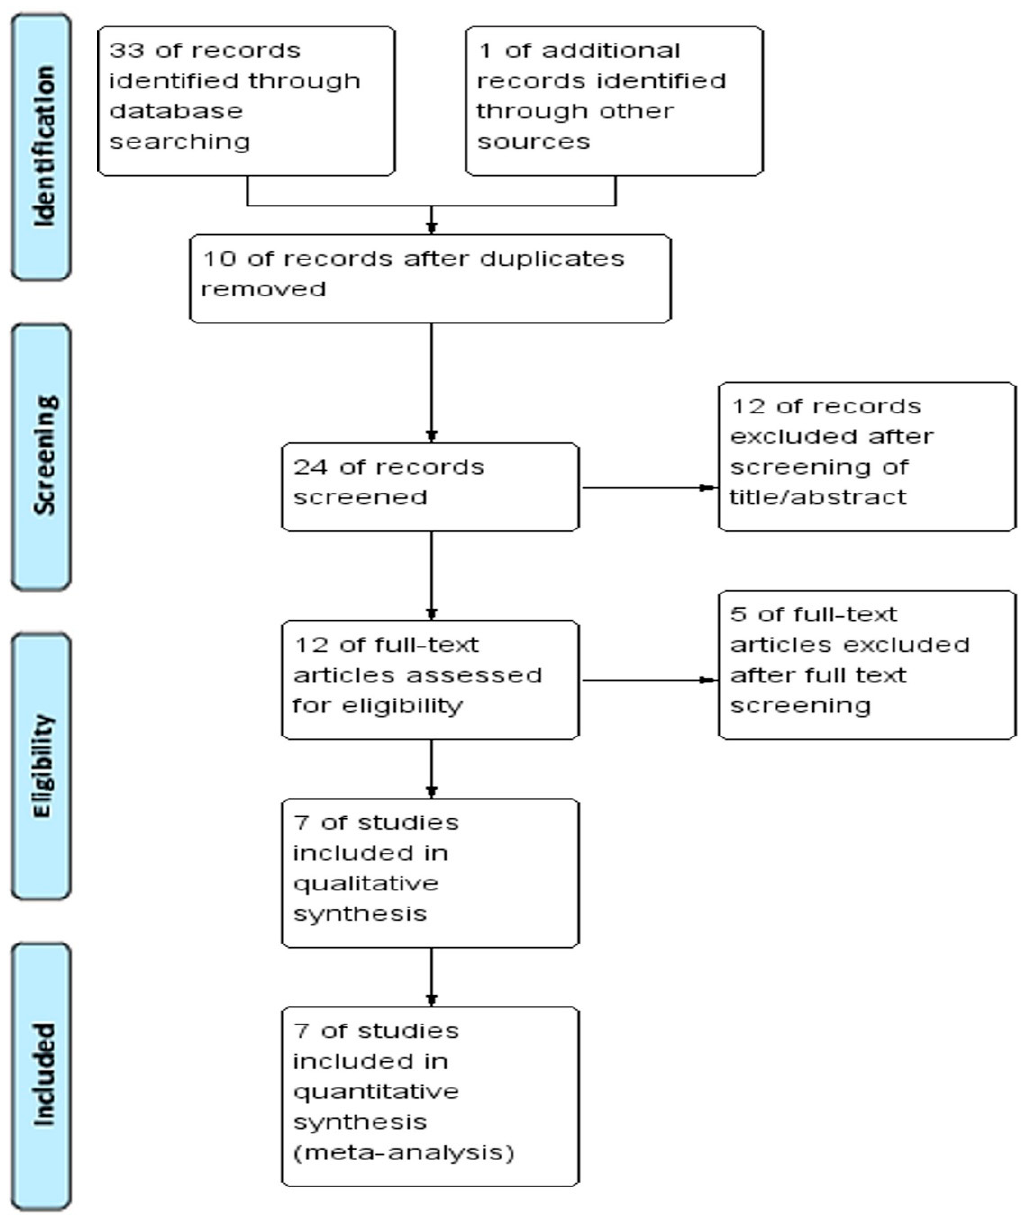
Figure 1. PRISMA flow diagram for the systematic review.